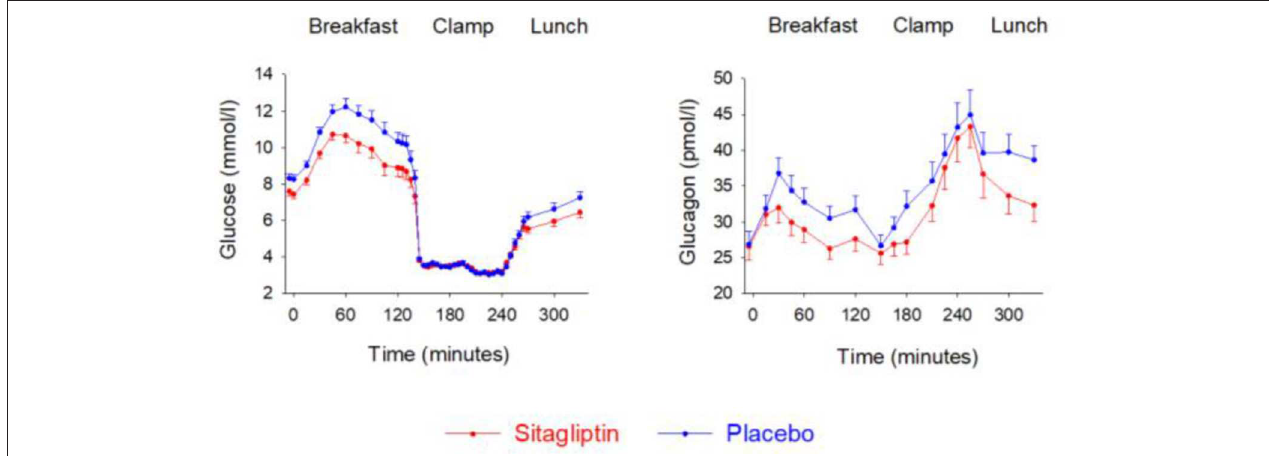
FIGURE 10 | Plasma levels of glucose and glucagon during breakfast, insulin-induced hypoglycemia and subsequent lunch in 28 elderly (65–84 years) subjects with metformin-treated type 2 diabetes after 4 weeks of add-on therapy with sitagliptin or placebo. Means ± S.E.M. are shown. Data from Farngren et al. (140). Reprinted with permission from